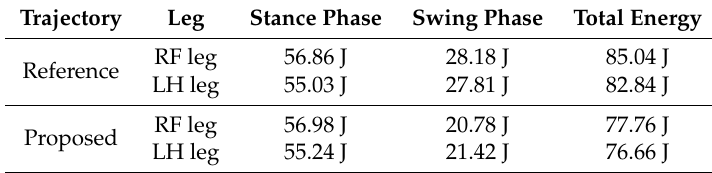
Table 6. The mean energy consumptions in